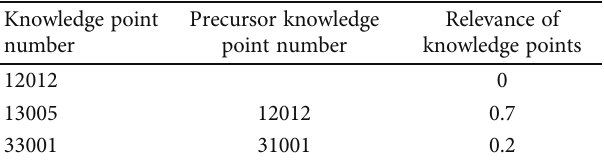
Table 5: Example of knowledge point relationship